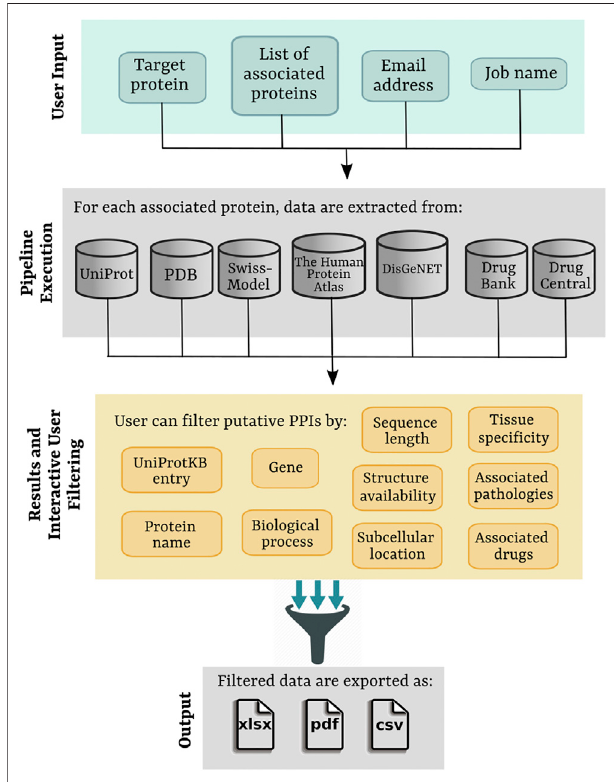
FIGURE 1 | Work fl ow of the PPI-MASS web server describing the four major layers of the platform to process MS-based proteomics data and to identify candidate proteins to establish PPIs with a target